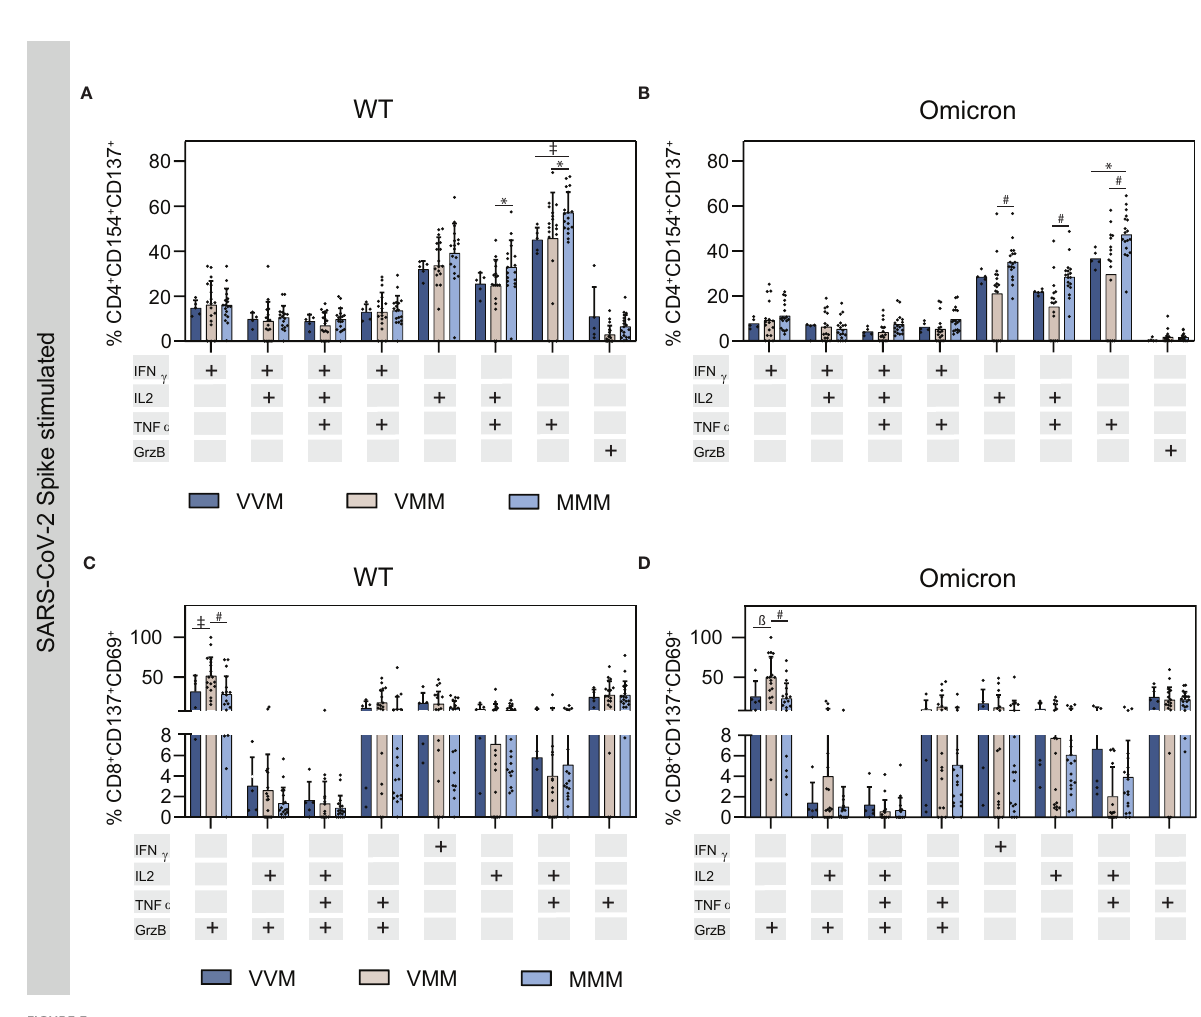
FIGURE 3 Cytokine production in activated T helper and cytotoxic T cells upon Spike stimulation on T4. (A, B) Cytokine production in activated T helper cells upon stimulation with WT (A) or Omicron BA.1 (B) S protein OPP. (C, D) Cytokine production in activated cytotoxic T cells upon stimulation with WT (C) or Omicron (C) S protein derived OPP. Statistical analysis was performed using Tukey ’ s multiple comparison test to compare the vaccine regimens with each other and S ̌ ida ́ k ’ s multiple comparison test to compare WT vs. Omicron for each vaccine (* p=0.05; ǂ p=0.01; ß p=0.001, #